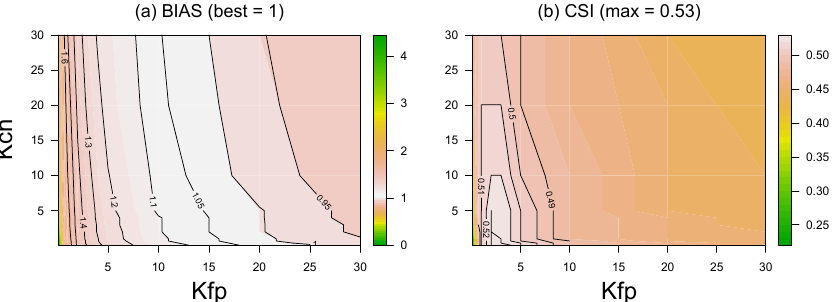
Figure 16. (a) BIAS and (b) CSI scores obtained by the model on the River Loing versus Copernicus data for all the parameter values tested and for another source of data: